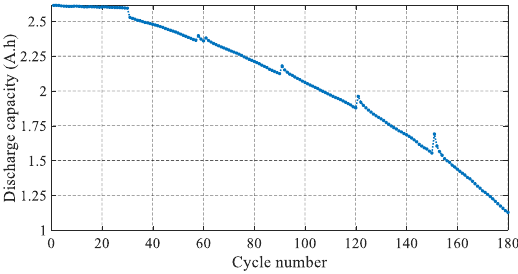
Figure 2. The decay of battery cell discharge capacity under 180 cycles.